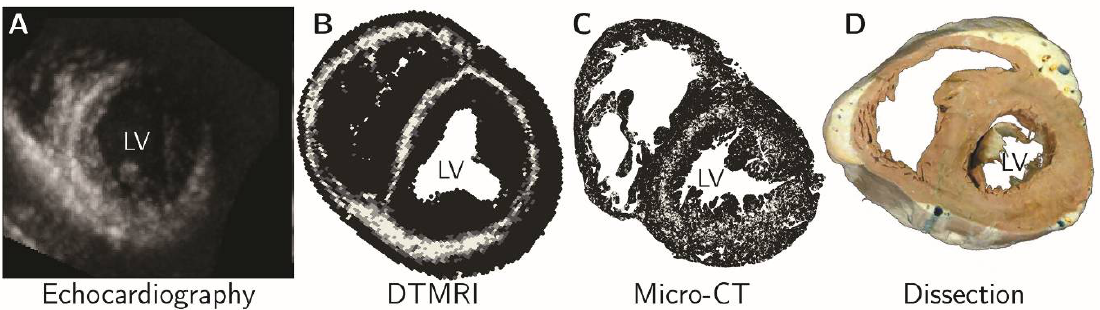
Figure 4. The morphological substrate for the enigmatic ‘echogenic bright line’ was resolved by multi-modality imaging. ( A ) The echogenic bright line viewed in the short axis derived from apical long axis images; Structure tensor analysis of diffusion tensor magnetic resonance imaging ( B ) and micro-computed tomography ( C ) data sets, white pixels indicate areas of circumferentially running myocytes; ( D ) This morphological arrangement it not easily appreciated in dissected specimens. Modified from Agger et al., 2016 [45].